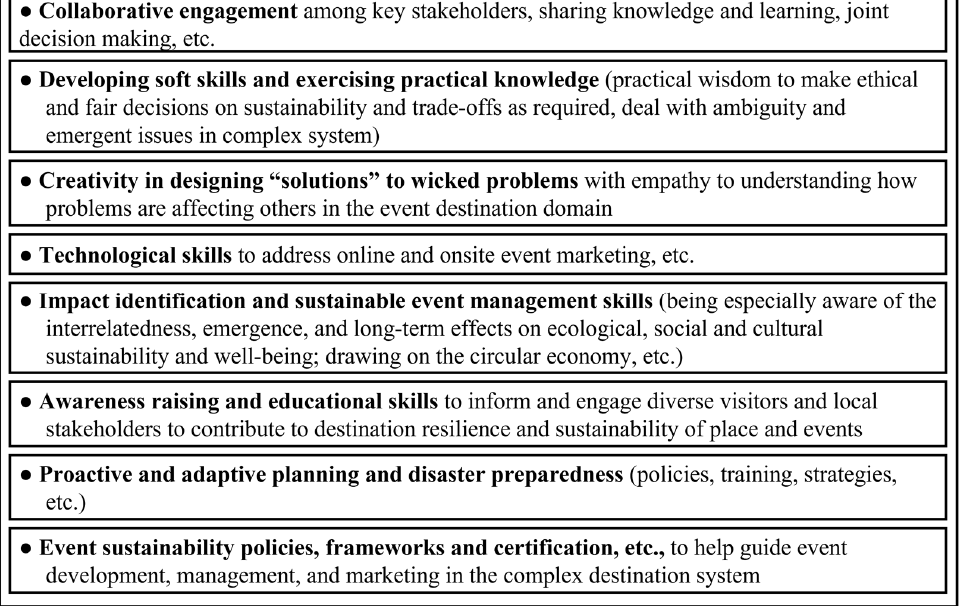
Figure 1. Some important dimensions for building resilience in the complex learning destination.